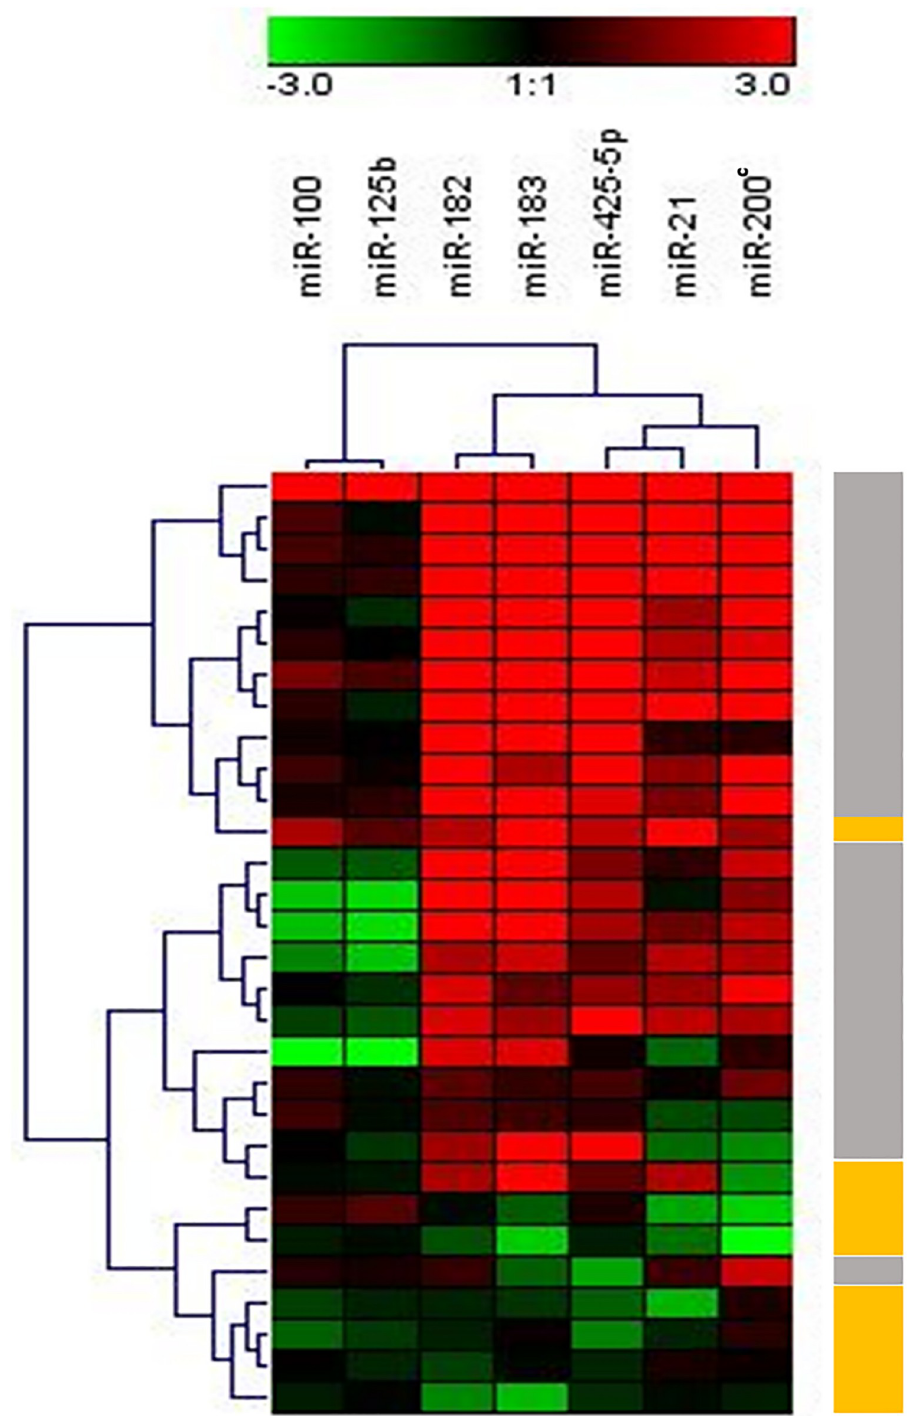
Fig 3. Heatmap and dendogram analysis of miRNA expression in normal and BC tissues. Fold expression data were Log2 transformed before analysis. miRNA profiling segregated the tumor tissues and the normal adjacent tissues. Left-hand side dendrogram corresponds to a hierarchical clustering of the tissue samples. The upper side dendrogram corresponds to a hierarchical clustering of miRNA expression in the FFPE tissues. Grey boxes denote tumor samples and yellow boxes denote normal adjacent